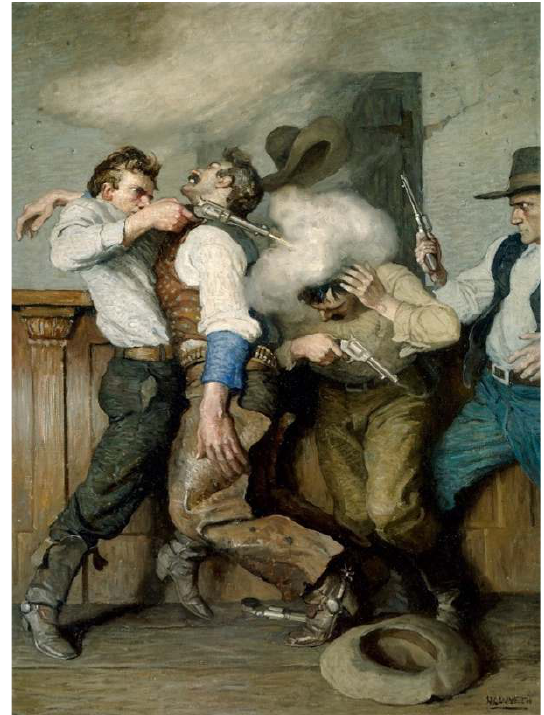
Figure 7. N. C. Wyeth, Gun fi ght . Oil on canvas